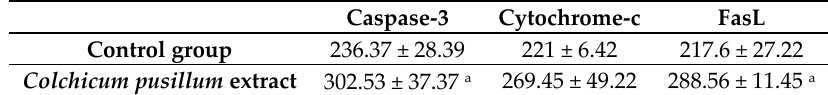
Table 2. The H-SCORE of Caspase-3, cytochrome-c and FasL in Colo-741 cells treated with Colchicum pusillum extract at 20 µg/mL concentration for 48